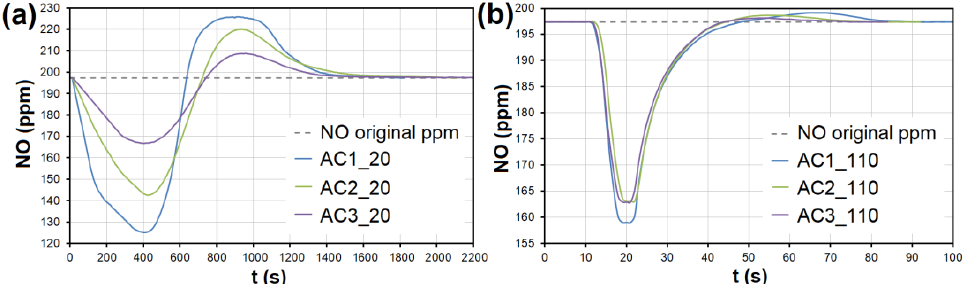
Figure 8. The adsorption curves showing NO adsorption on AC at adsorbent temperatures of ( a ) 20 °C and ( b ) 110 °C. The curves also show forced the desorption effect in the ranges of ( a ) 630 – 2150 s and ( b ) 43 – 93 s. AC1-3 — activated carbon at different granulometric fractions (see Table 1).